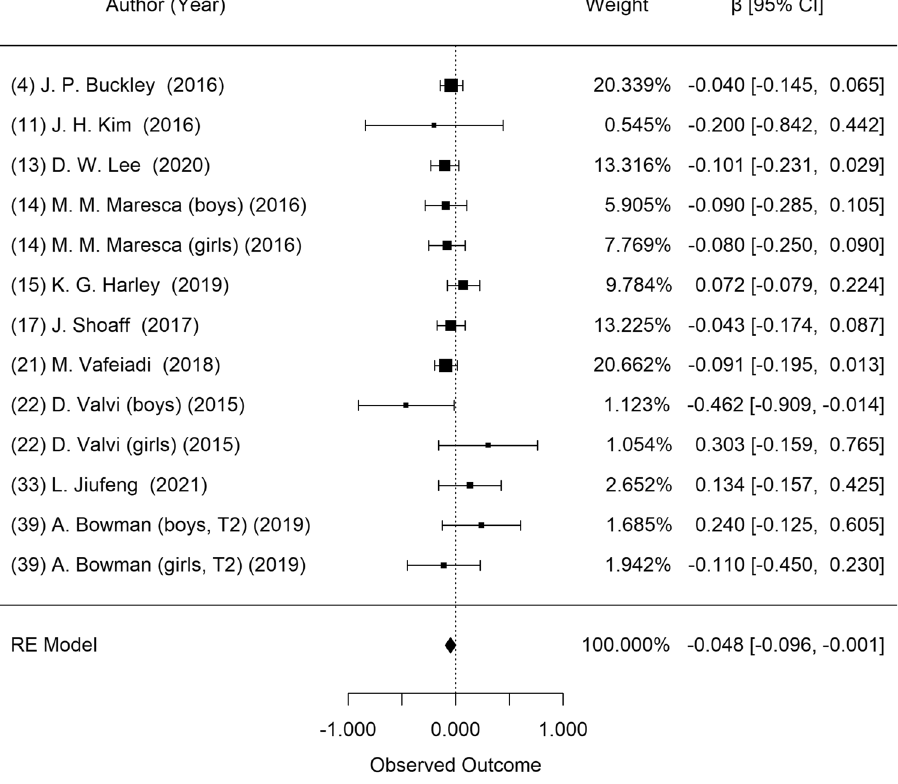
Figure 2. Forest plot of studies on the association of DEHP exposure with BMI z-scores: longitudinal studies. Estimates were standardized as β and 95% confidence intervals as one unit increase of natural log of DEHP